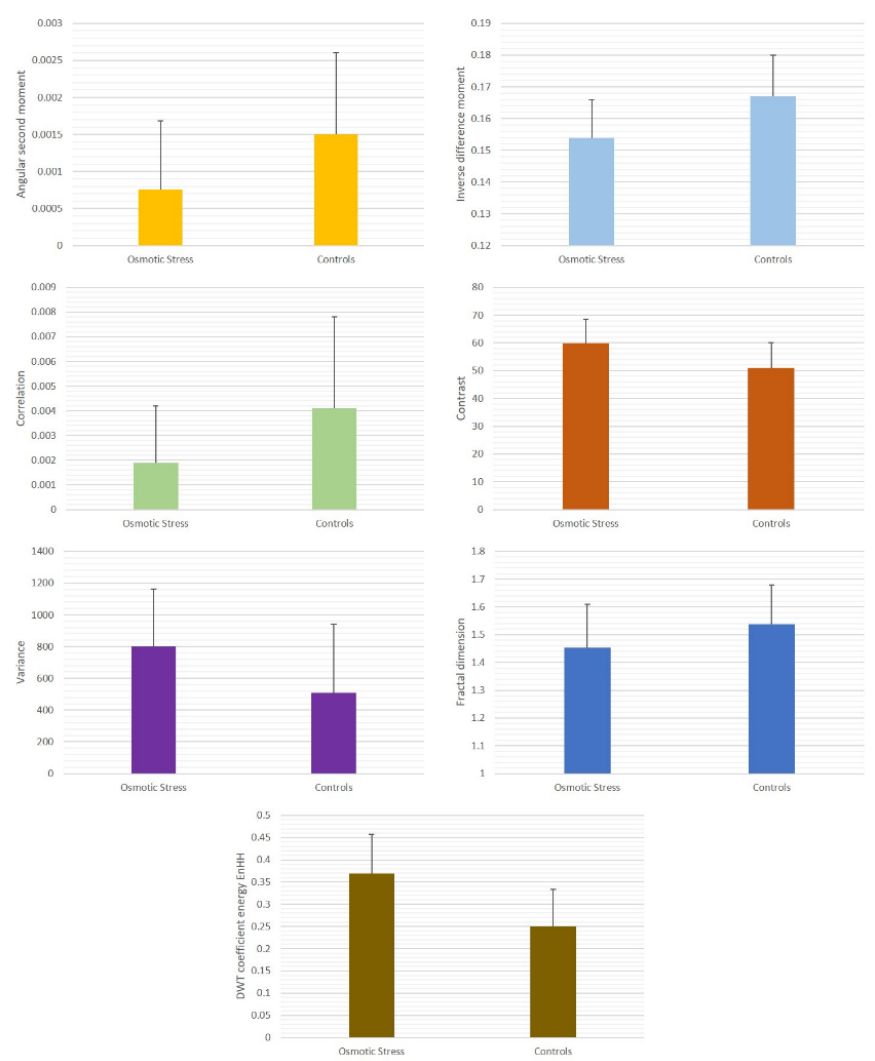
Figure 4. Average values of nuclear GLCM indicators in cells exposed to hyperosmotic environment and controls. Table 1. Average values of GLCM, fractal and DWT indicators of nuclear ROIs on cells exposed to hyperosmotic environment and controls. * p < 0.05 ** p < 0.01.